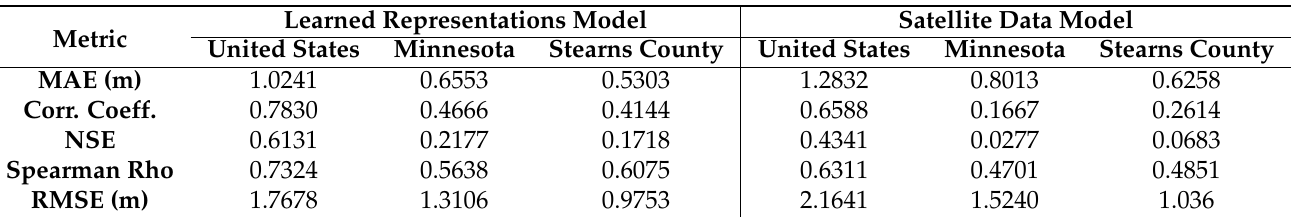
Table 2. Results